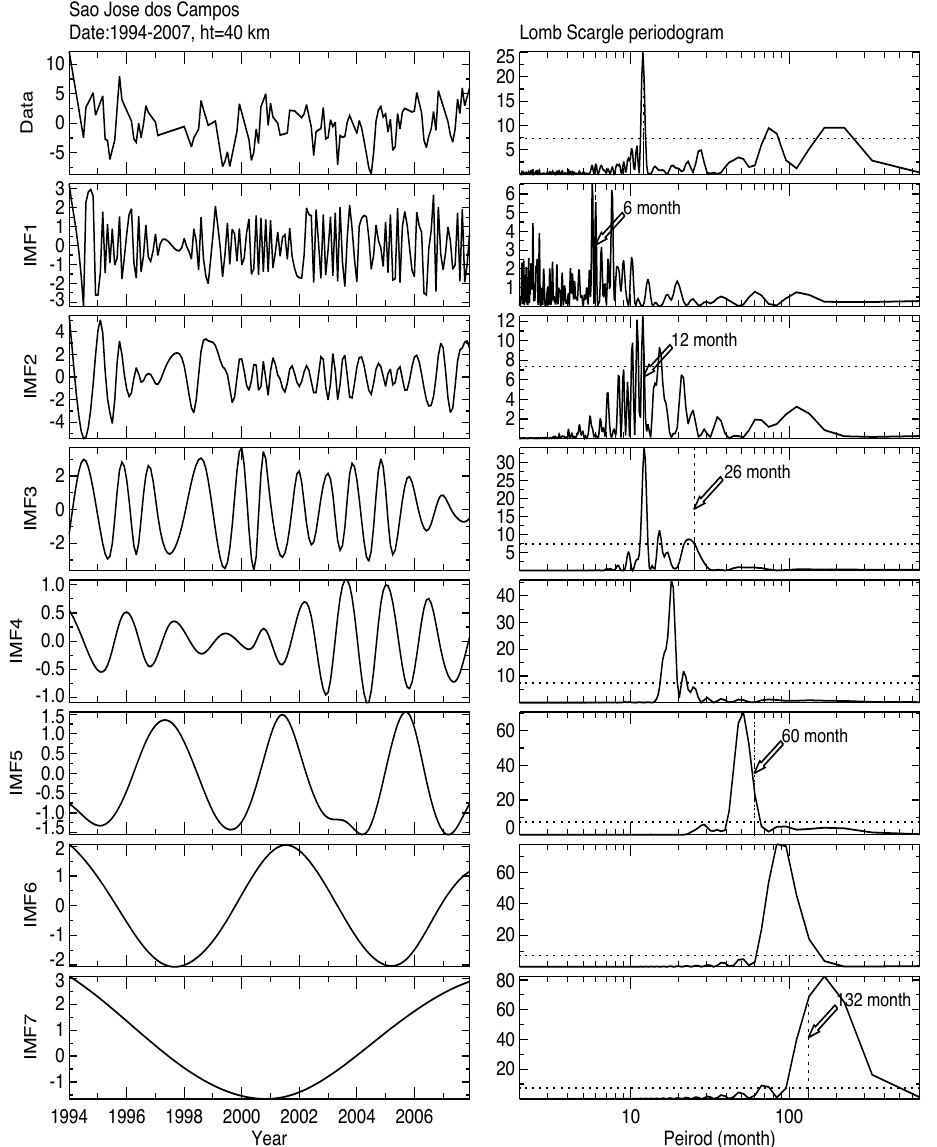
Fig. 5. Various IMFs obtained for temperature anomalies over São José dos Campos location (left panels) and corresponding LS periodograms Figure 5: Various IMFs obtained for temperature anomalies over São José dos (right panels). Dashed horizontal line shows 90% confidence Campos location (left panels) and corresponding LS periodograms (right panels). Dashed horizontal line shows 90% confidence level.